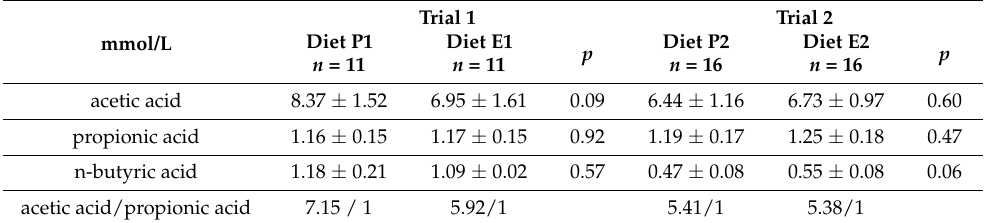
Table 4. Fecal concentrations of organic acids (mean ± SD (mmol/L)) and the ratios of fecal acetic acid to propionic acid for both trials.